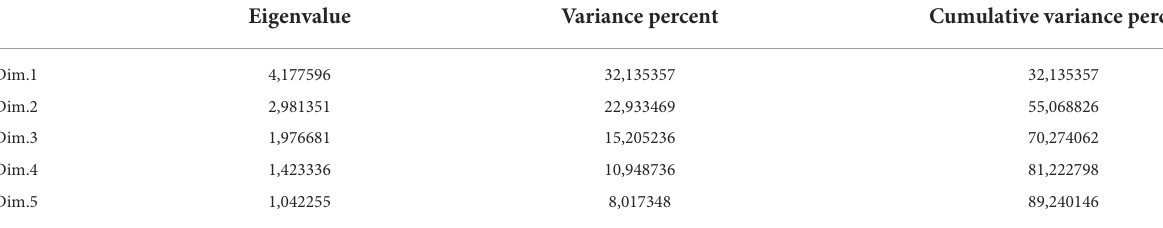
Source:Ministryofeconomicaffairsanddigitaltransformation(statesecretariatfordigitalizationandartificialintelligencedepartment). TABLE 2 Percentage of inertia explained by each FAMD